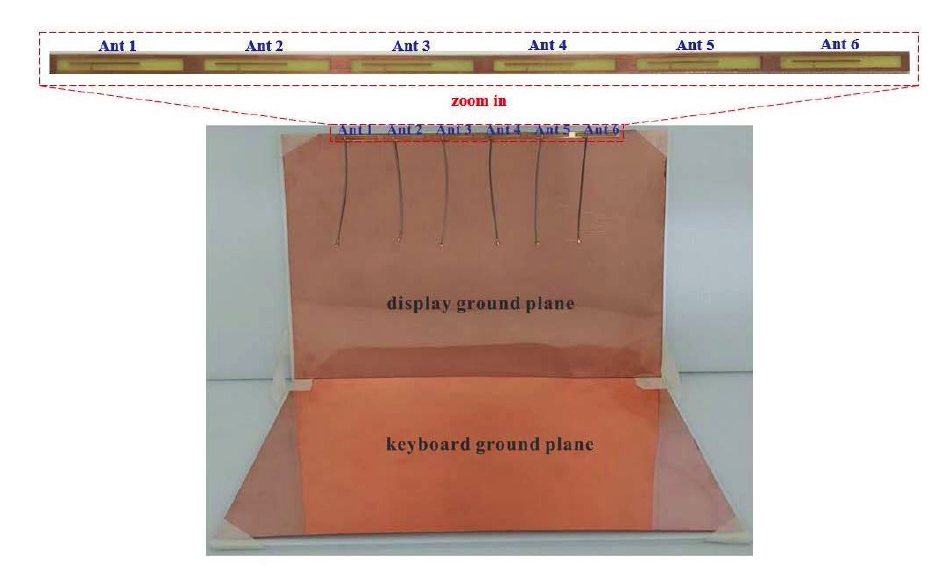
Figure 3. Overall configuration of the 5G MIMO six-antenna system.